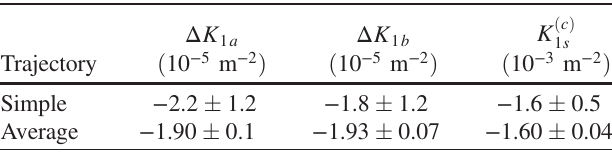
TABLE II. Corrector strengths estimated from simple